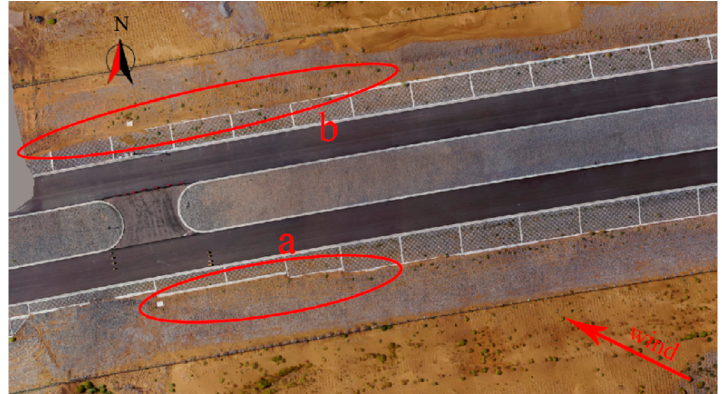
Figure 16. Distribution of on-site sand accumulation at K167 + 670 of Wuhai–Maqin highway.